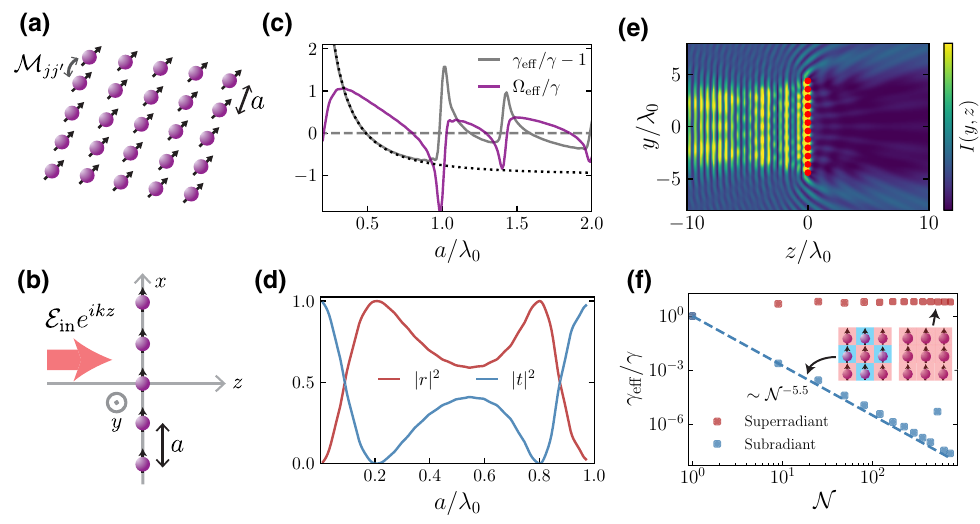
FIG. 8. (a) Two-dimensional quantum-emitter array illustrated as a regular pattern of near-field coupled dipoles with lattice constant a . (b) The array is placed in the x - y plane and is illuminated by a plane wave with wave number k . (c) Effective decay rate γ eff and frequency shift (cid:9) eff of an array consisting of 20 × 20 atoms as a function of a /λ 0 . The dotted black curve shows the approximation = γ 3 (λ / a ) 2 valid for lattice constants a < λ | r | 2 and transmission coefficient | t | 2 = | 1 + r | 2 of an atomic array γ eff 0 0 . (d) Reflection 4 π as a function of the lattice constant a (for resonant illumination of the emitters). (e) Calculated intensity profile I ( y , z ) (in arbitrary units) in the y - z plane for an array of 12 × 12 atoms (indicated by red dots) with lattice constant a = 0.8 λ 0 , which is resonantly illuminated by a plane wave. (f) Targeted addressing of super- and subradiant states of a 2D array with a = 0.2 λ 0 as a function of the number of emitters in the array N . As indicated in the inset, subradiant states are targeted by illumination with antisymmetric phases f nm = ( − 1 ) n + m in a checkerboard pattern while superradiant states are obtained from uniform, symmetric illumination. The effective decay rate of the subradiant states scales proportional to N − 5.5 as shown by the dashed line. vary over the array, any surface mode, which is acciden- tally excited, would radiate in directions other than z .